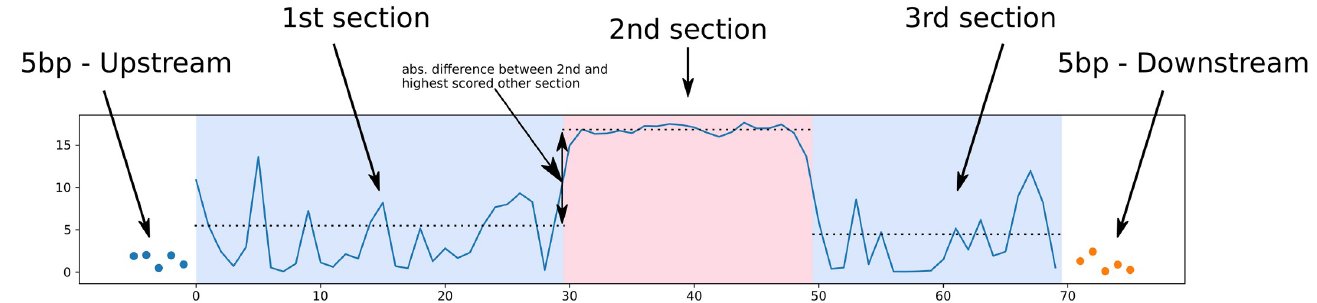
Fig 1. Approach used to identify subregions within CNEs via change point analysis. The scores used to annotate the CE region are displayed on the y-axis. The position in the investigated CE region is shown on the x-axis. In total there are five sections, 5 bp up and downstream, 1st, 2nd and 3rd subregions. The transitions from blue to red background indicate the position of the two identified change points. The up and downstream scores are shown as dots while the scores in the CE region are a continuous blue line.